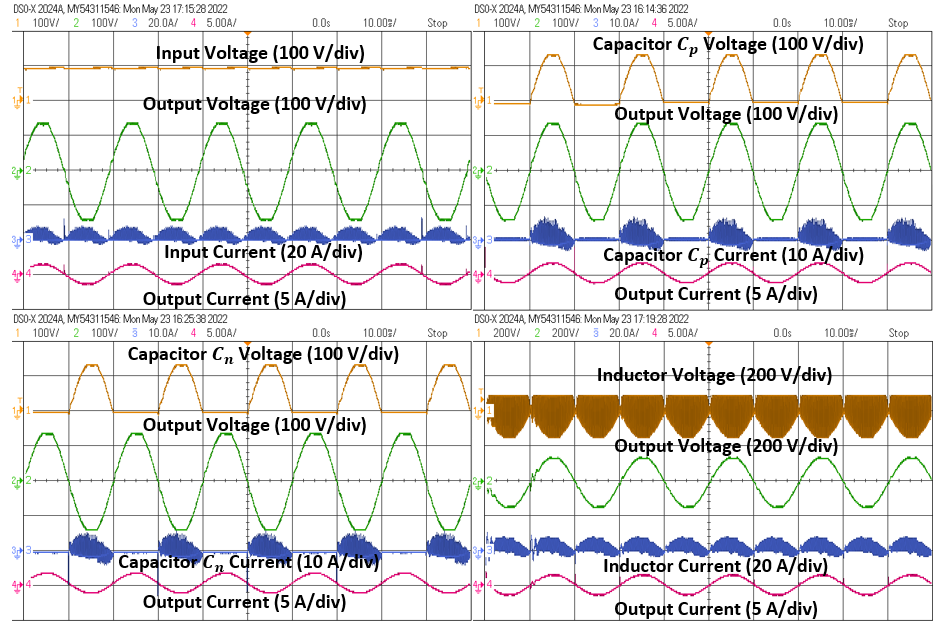
Figure 10. Steady-state response of mode 3 at G = 1.5.